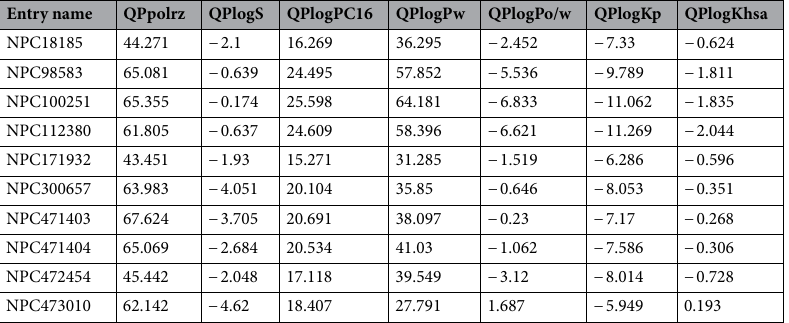
Table 3. ADME/T properties: adsorption, distribution, metabolism, excretion, and toxicity.